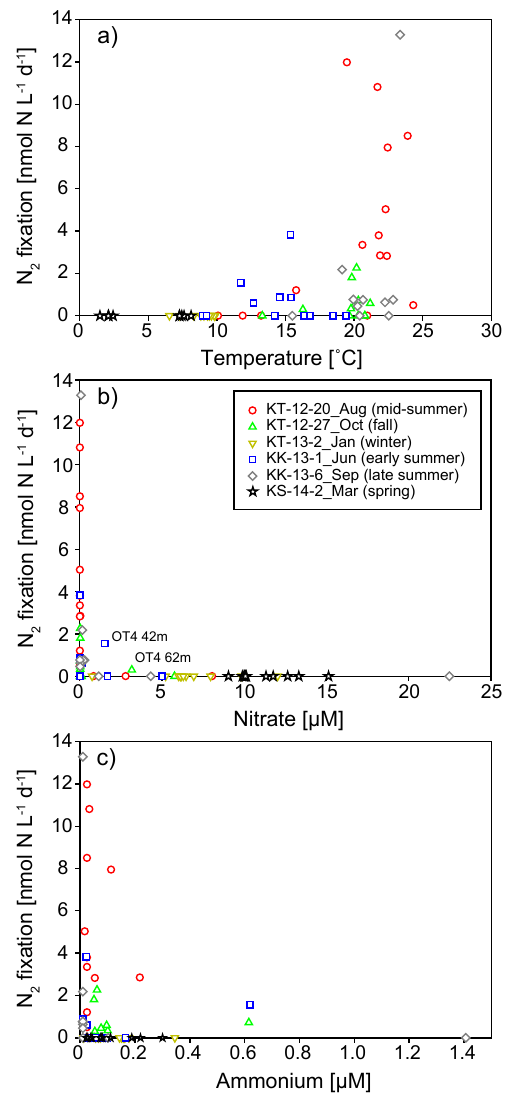
Figure 6. Relationship between nitrogen fixation [nmolNL − 1 d − 1 ] and (a) temperature [ ◦ C], (b) nitrate [µM], and (c) ammonium [µM] for all six